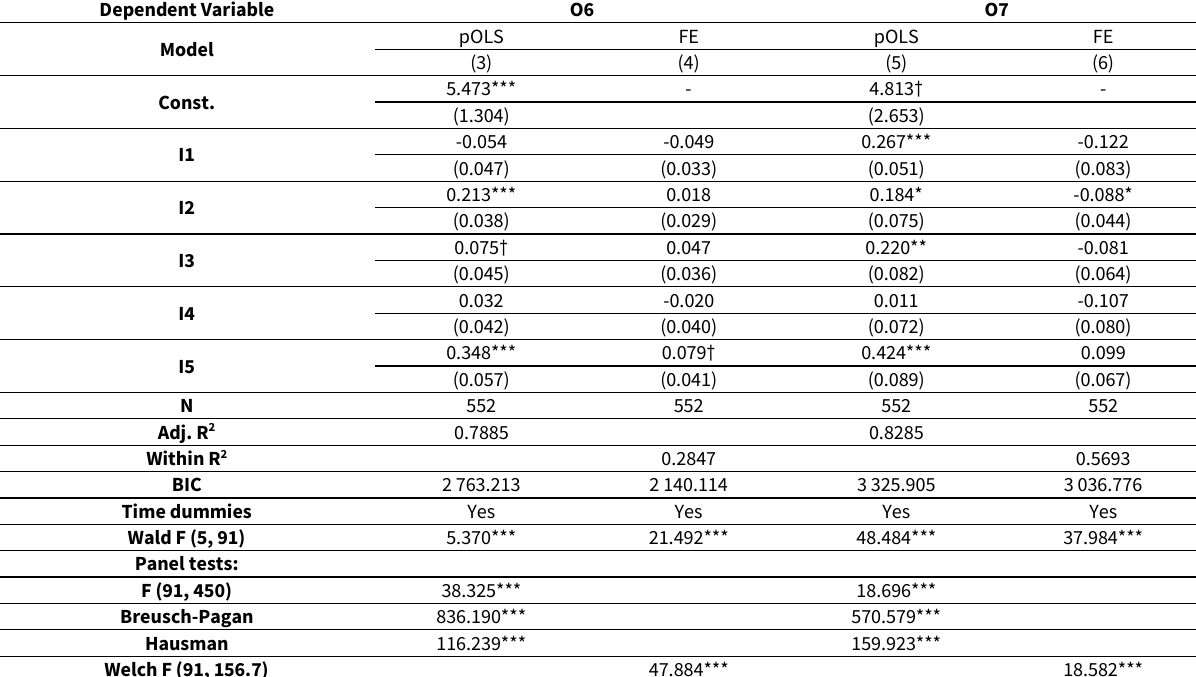
Table 8. Results of regressions